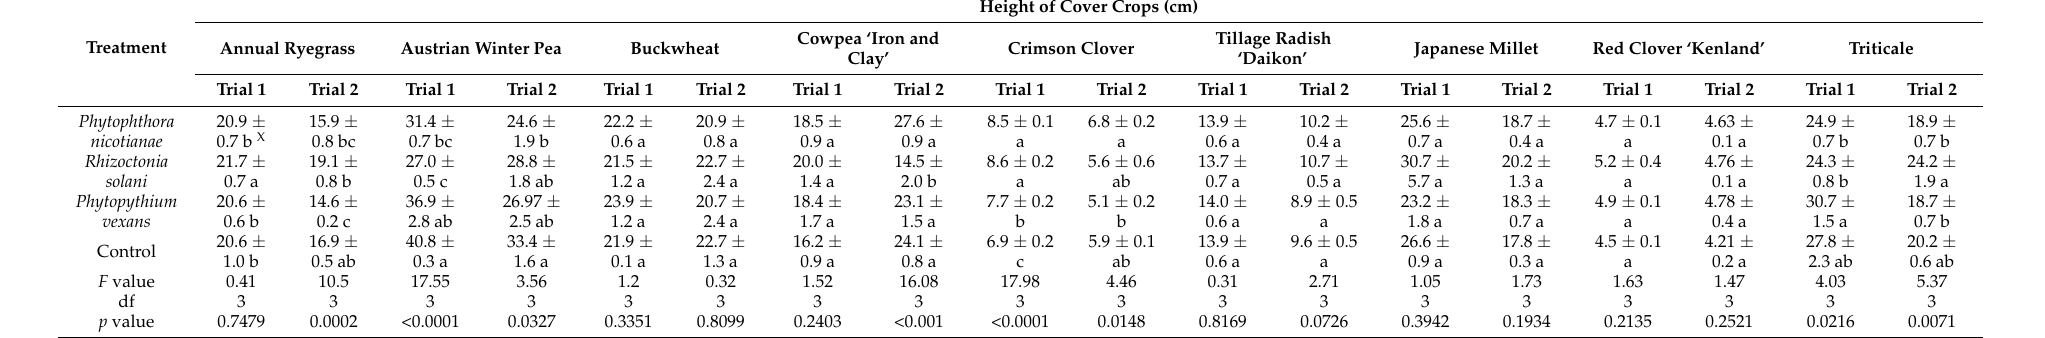
Table 2. Total height of different cover crops with the respective of Phytophthora nicotianae , Phytopythium vexans , Rhizoctonia solani, and control.